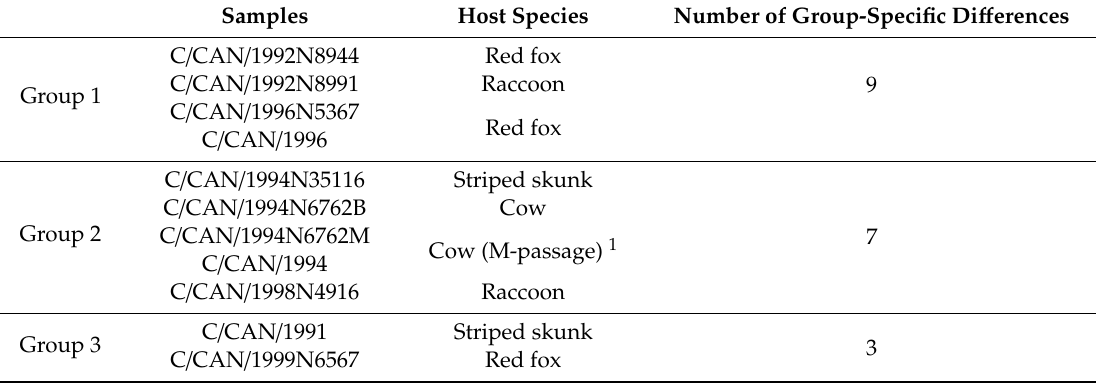
Table4. GroupsofvirusesfromERAvaccine-inducedrabiescasesshowingsimilarpatternsofnucleotide exchanges compared to the progenitor ERA-BHK21 vaccine virus strain at the consensus level.